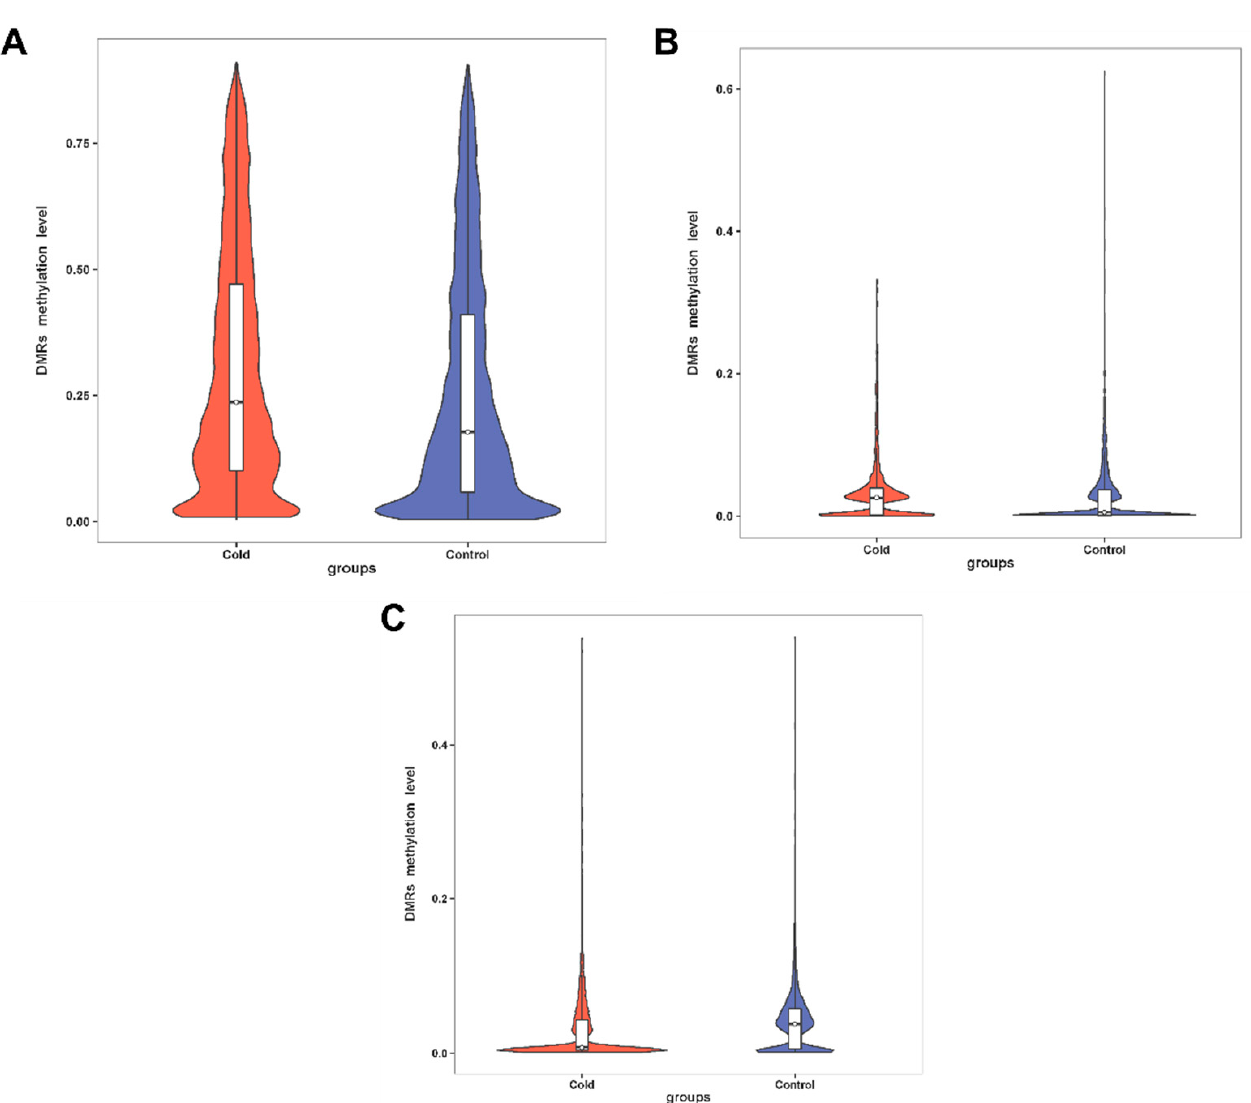
Figure 5. Boxplot analysis of the methylation level of DMRs in the cold vs. control group of the H . longicornis adults. ( A ). Boxplot analysis of the CG DMR methylation level. ( B ). Boxplot analysis of the CHG DMR methylation level. ( C ). Boxplot analysis of the CHH DMR methylation level.